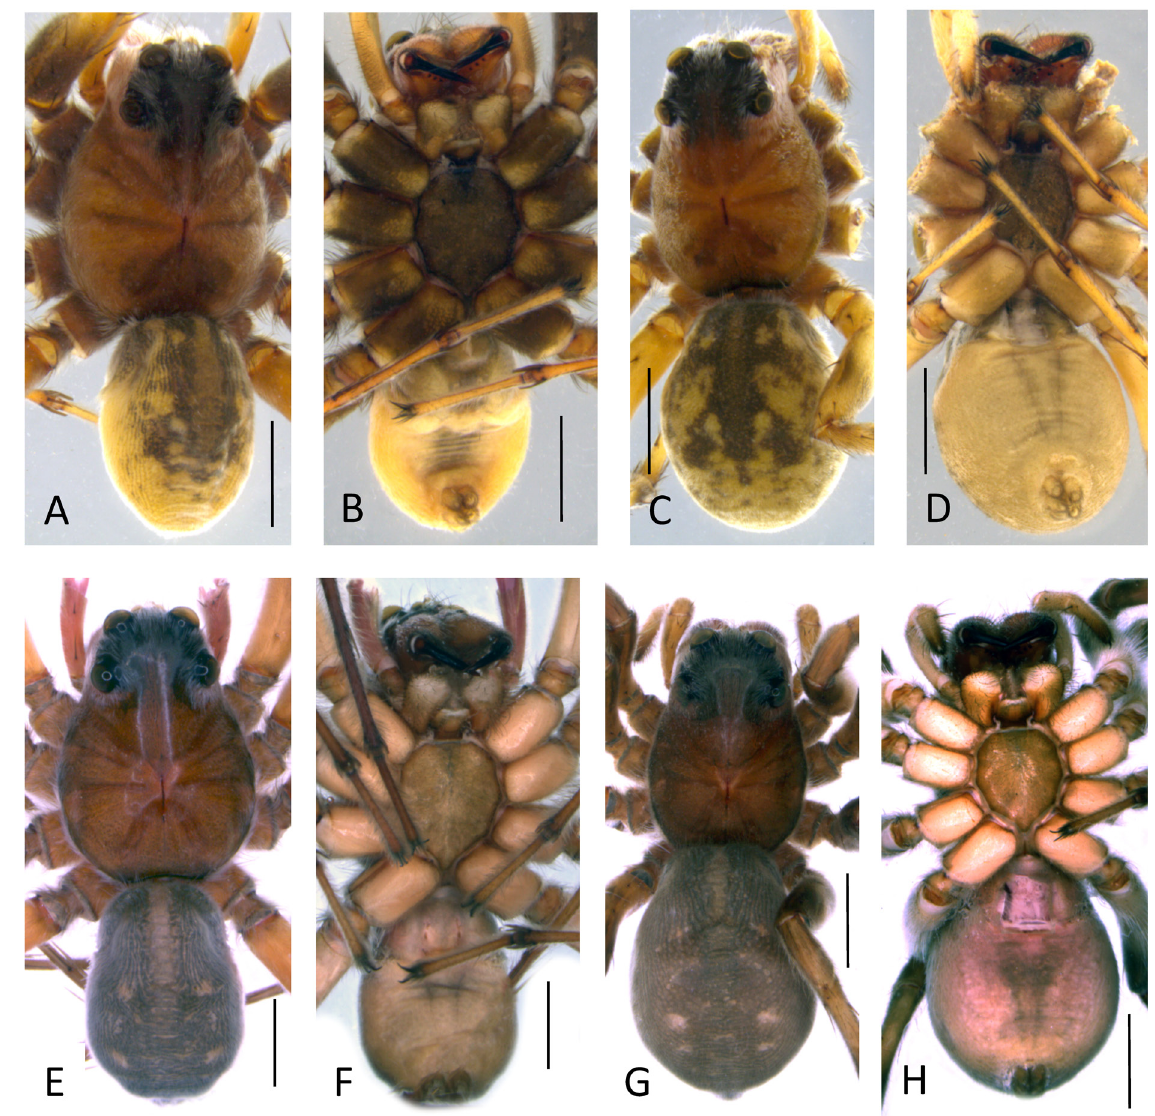
Fig. 18. Tetralycosa Roewer, 1960, microscopic photographs showing dorsal and ventral